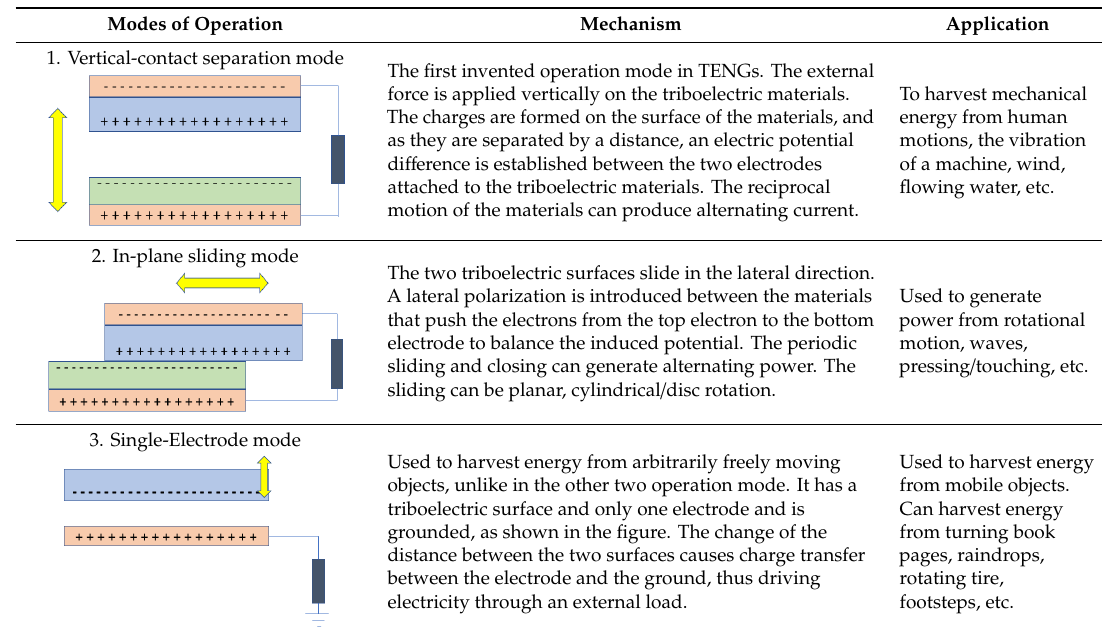
Table 3. Comparison of the working principle of various modes of operation of TENG.